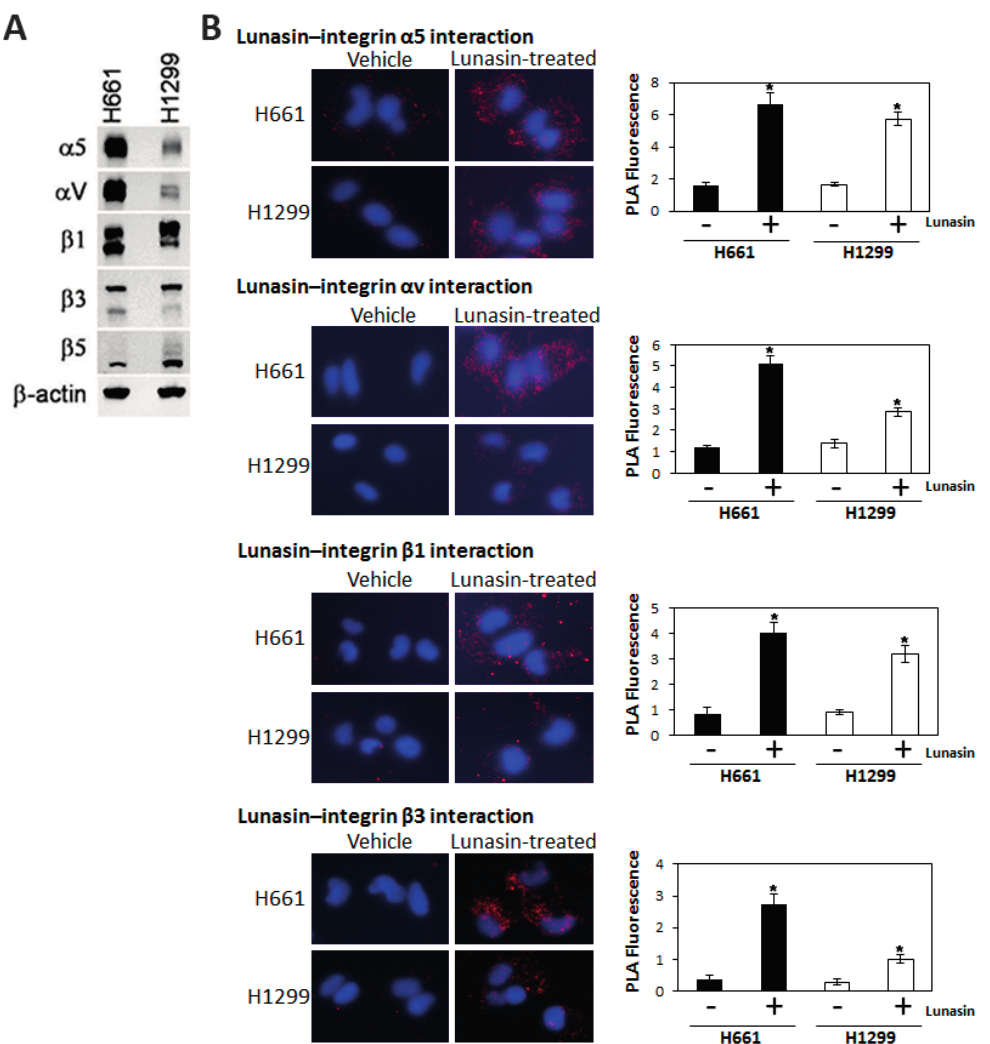
Figure 4. ( A ) Analysis of integrin subunit expression in NSCLC cell lines H661 and H1299. Protein extracts were subjected to immunoblot analysis using antibodies specific for the indicated integrin subunits; ( B ) Detection of lunasin interactions with specific integrin subunits in situ . Left -hand panels show representative PLA analyses of lunasin and the indicated integrin subunit; Right -hand panels show the quantitation of fluorescence for each interaction. Fluorescence is expressed as relative fluorescence per cell. Data shown are the mean ± SD obtained in three independent experiments; asterisks indicate statistically significant difference ( p < 0.05) from the vehicle-treated